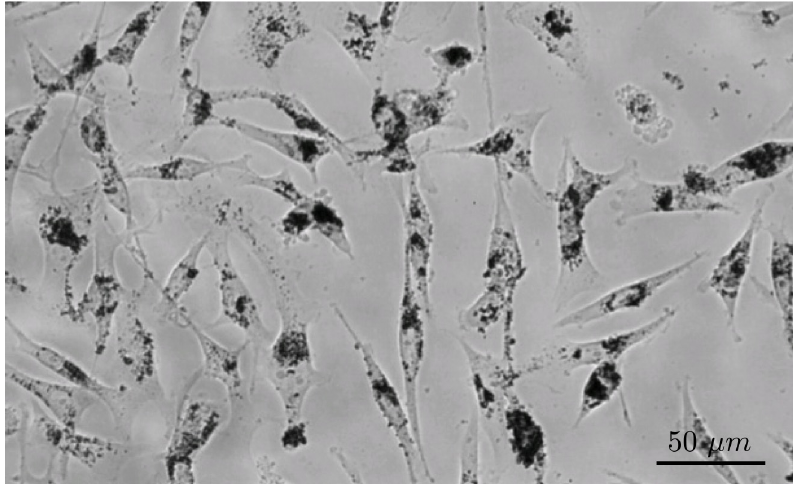
Fig 8. Bright-field image of MDA-MB-231 cells in culture with internalized iron oxide nanoparticles.